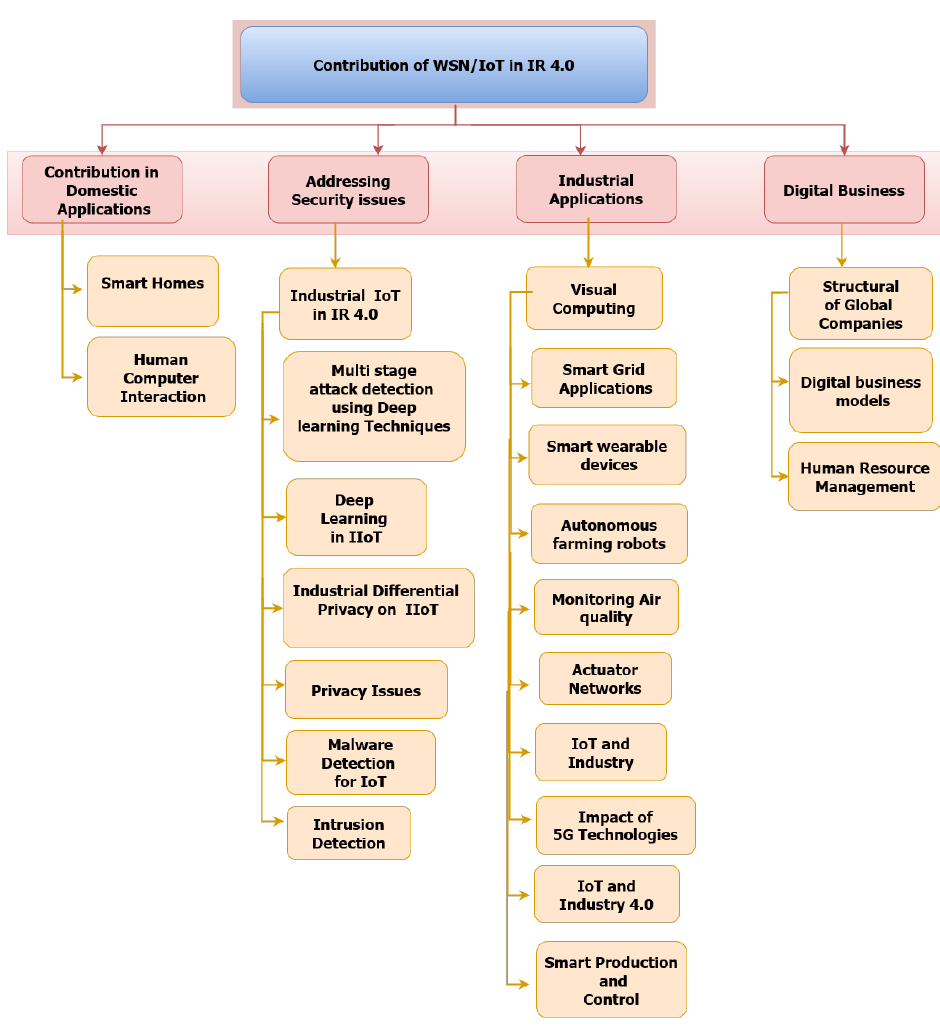
Figure 8. Taxonomy of existing